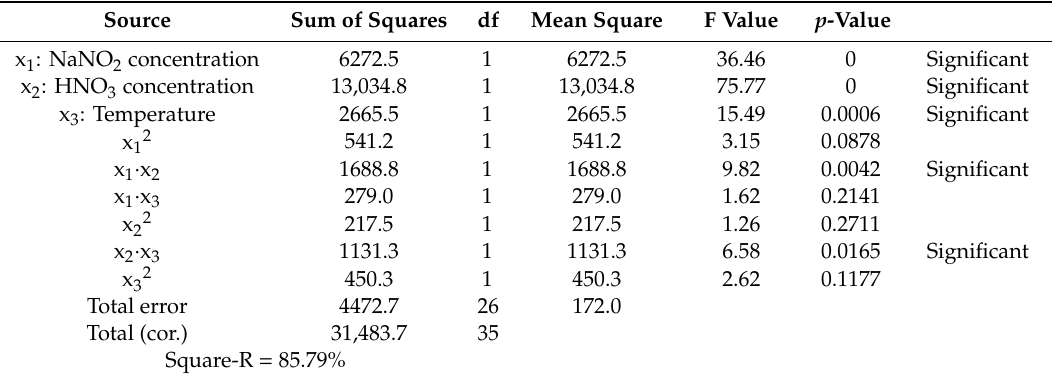
Table 2. ANOVA for the response surface quadratic model where response was TOC removal after 30 min, Y 1